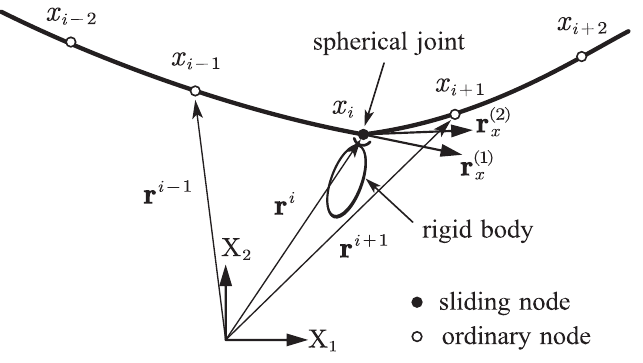
Figure 6. Sliding joint